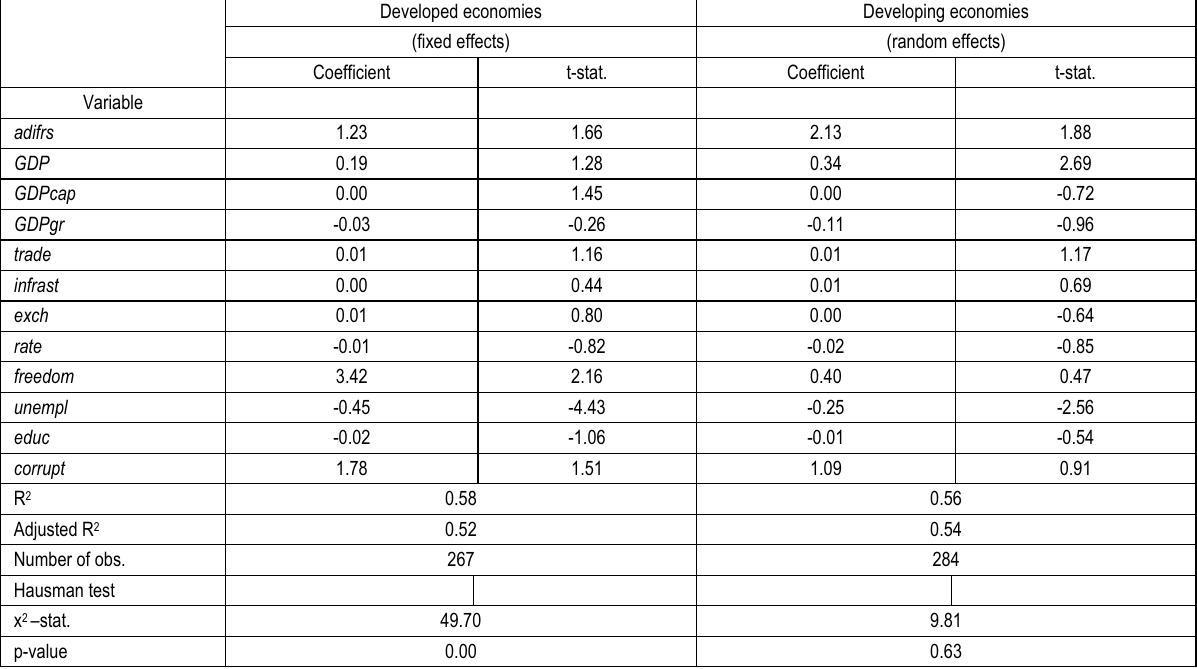
Table 2 . Panel data results – developed and developing